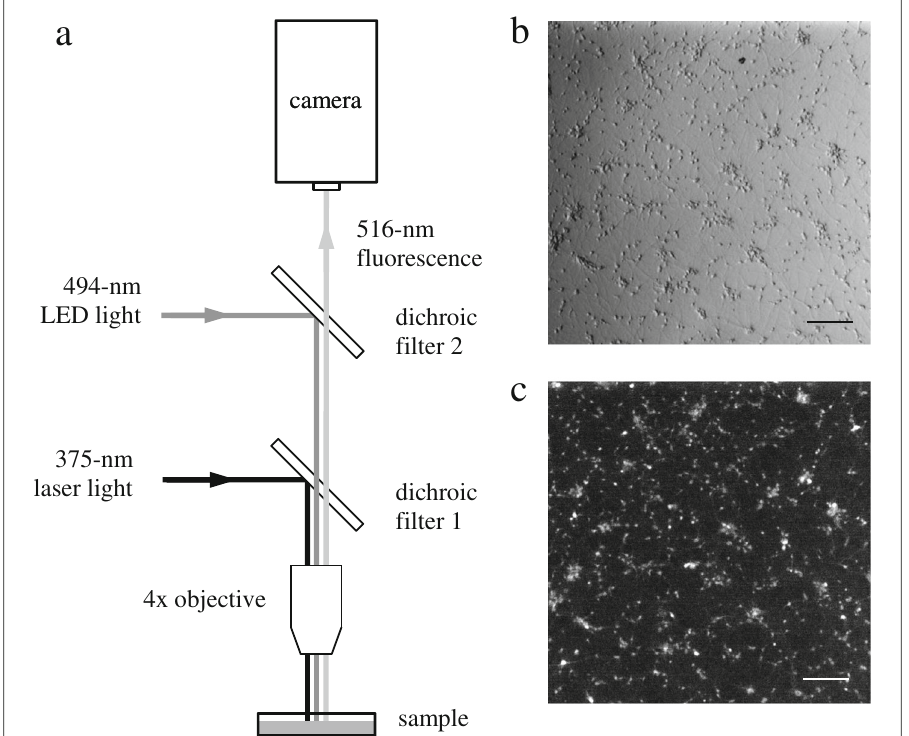
Fig. 1 a Schematic diagram of the apparatus. Field-of-view (FOV) b under Bright-field illumination and c of corresponding calcium indicator (Fluo-4) fluorescence. Scale bars: 200 μ